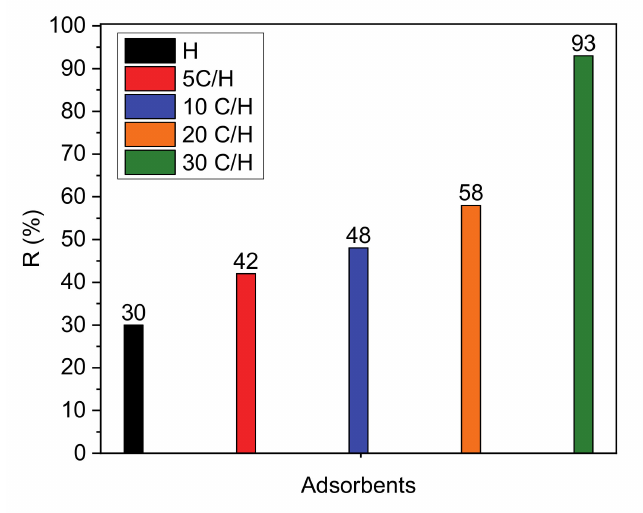
Figure 4. E ffi ciency of paracetamol removal for halloysite (H) and halloysite-carbon adsorbents (concentration of adsorbate solutions, 50 mg / dm 3 ; mass of adsorbent, 0.5 g; temperature 25 ◦ C).